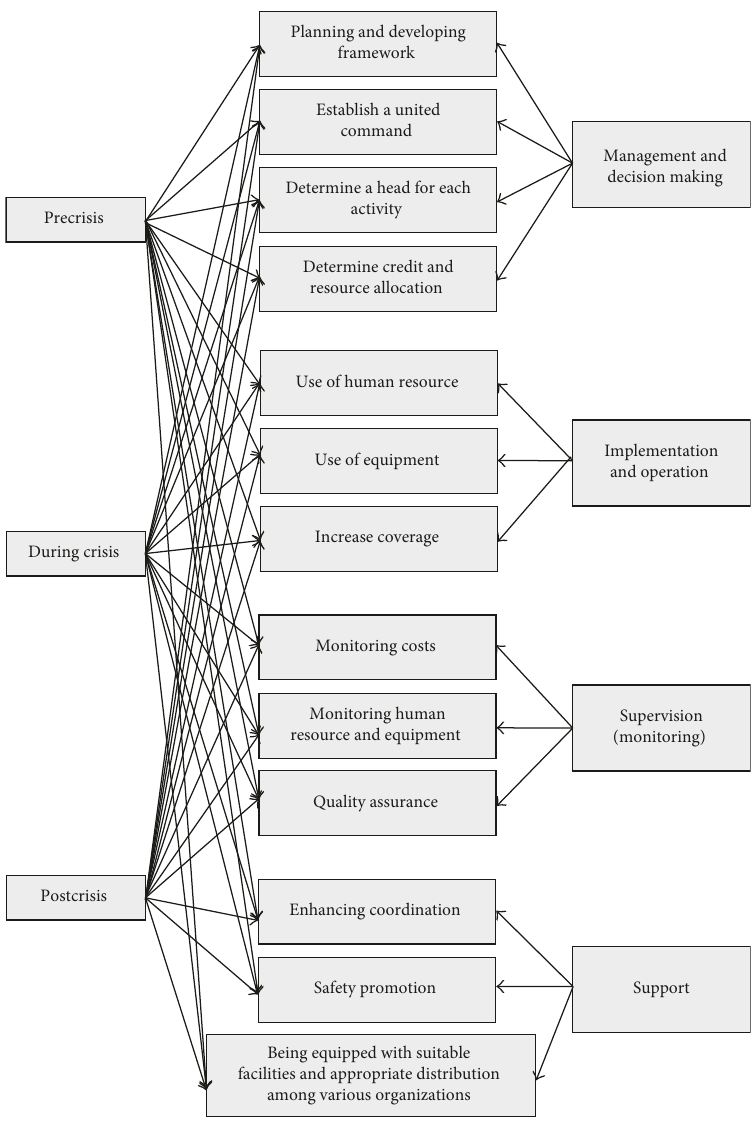
Figure 4: Analytic hierarchy process in earthquake disaster